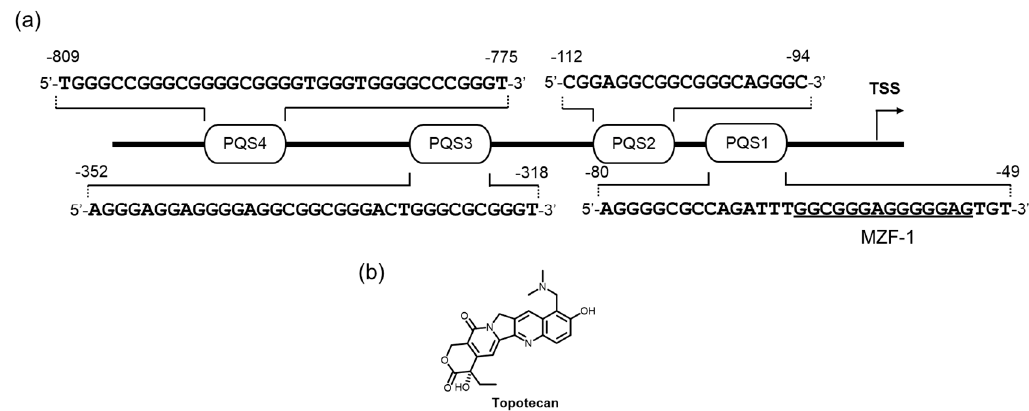
Figure 9. ( a ) The c- myb promoter has multiple PQSs. ( b ) A molecule interacting with its G4 DNA and efficiently repressing MYB protein